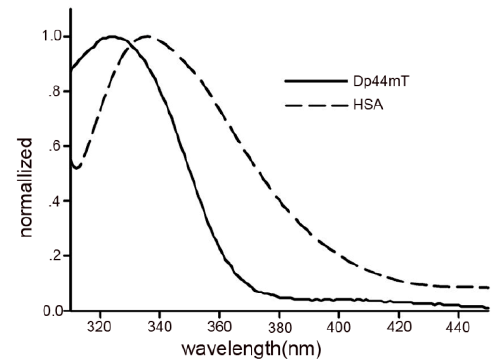
Figure 7. Overlap of the fluorescence spectrum of HSA and absorption spectrum of Dp44mT indicated